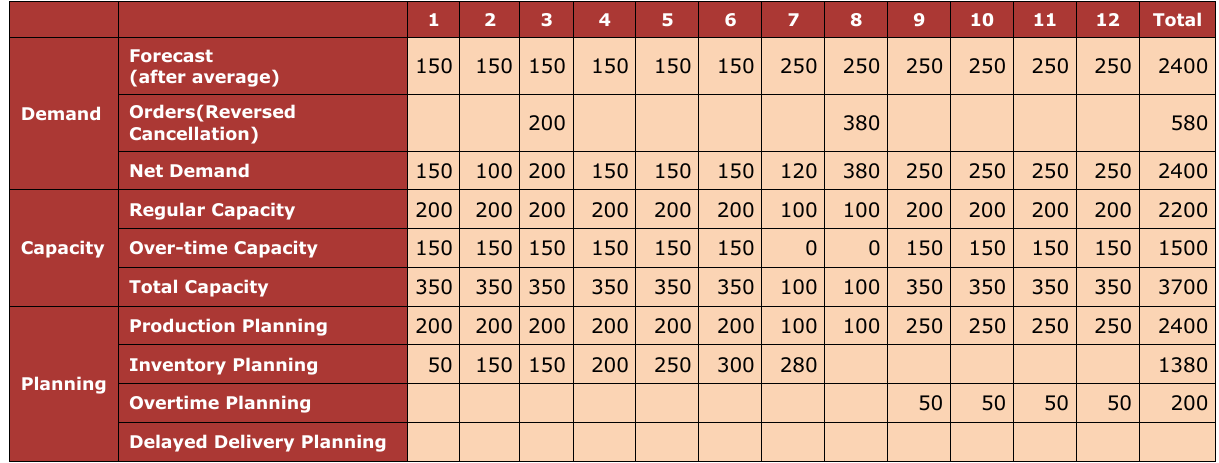
Table 3. Optimization Process considering In-time Delivery, Overtime Expenses and